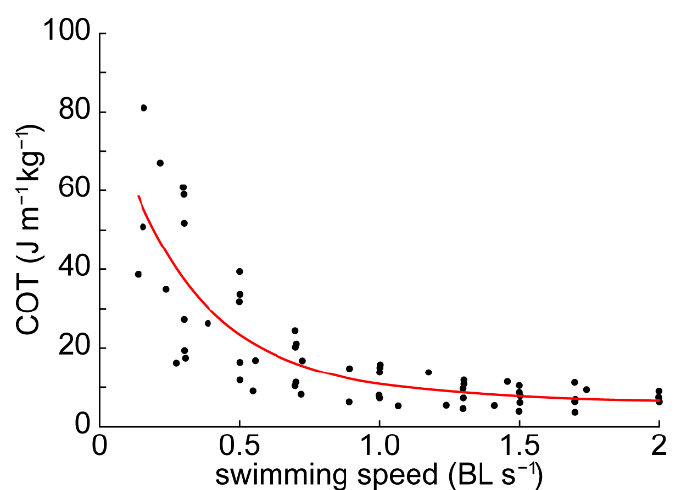
Figure 2. Cost of transport (COT). The metabolic cost of swimming at speeds (U) ranging from 0.14 to 2.0 BL s − 1 decreased exponentially with swimming speed. The equation for the fitted line (solid red line) is COT = α e β U + γ e δ U , where α = 78.05 j m − 1 kg − 1 , β = 3.39 s BL − 1 , γ = 9.79 j m − 1 kg − 1 , δ = − 0.20 s BL − 1 (R 2 = 0.69).